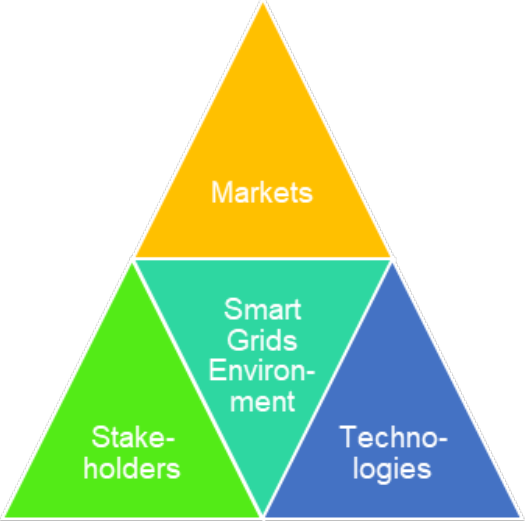
Figure 1. Three-layer research model for smart grids environments (adapted from ERA-Net Smart Grids Plus [1,2]).